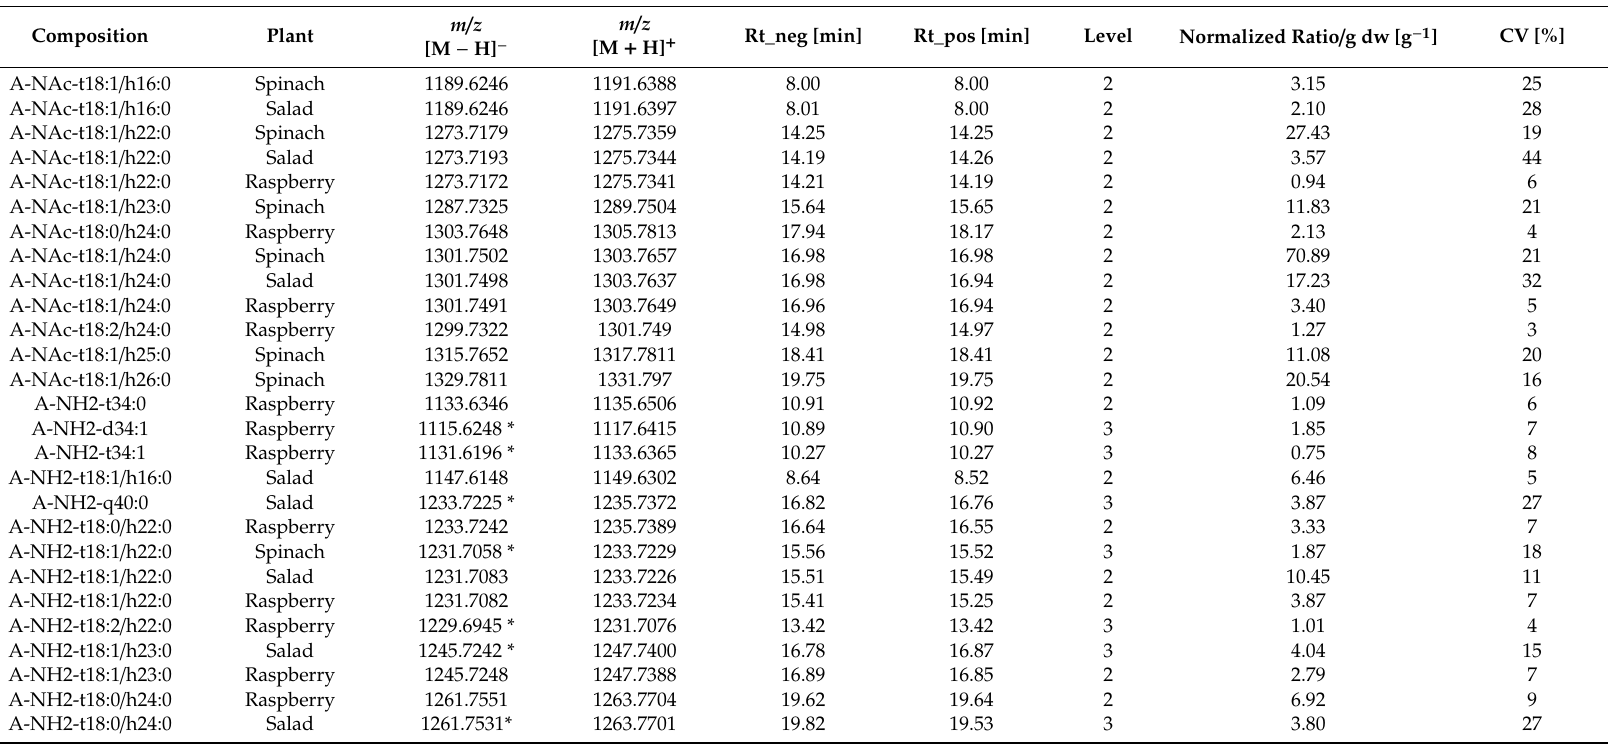
Table A1. Overview of GIPCs annotated in salad, spinach, strawberries and raspberries. The precursor ion m / z and retention times are listed as provided by the LDA display results function. In cases where only matching retention times but no m / z were explicitly shown by the LDA, because only one MS2 spectrum was annotated (level 3, level 3**), corresponding values (marked with an asterisk*) were manually assigned at the peak maximum using Thermo Scientific FreeStyle. In the Level column the levels of identification are listed. For all annotated GIPCs, accurate mass and retention times were observed. Their level of identification depends on